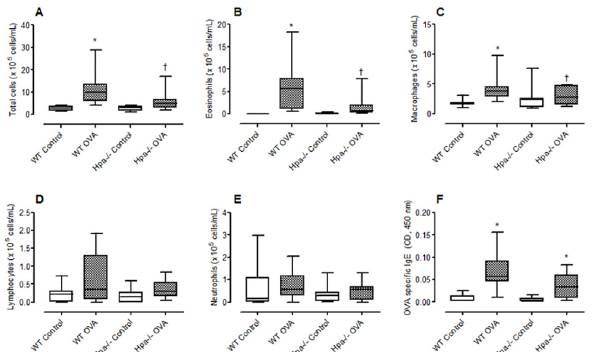
Fig 5. Effect of heparanase gene deletion on allergic inflammation induced by ovalbumin (OVA). Box plots showing (A) total cell, (B) eosinophil, (C) macrophages, (D) lymphocytes, (E) neutrophils in bronchoalveolar lavage fluid and (F) OVA specific IgE in serum in control and OVA immunized and challenged mice. Mice were sensitized by repeated i.p. injections with 10 μ g OVA or were non-sensitized (controls). All mice received three i.n. instillations with 20 μ g OVA and lavage was undertaken 24 h after the last intranasal administration of OVA. Data expressed as blox plots (median, 25 – 75 percentile) with whiskers representing 5 – 95% confidence interval (7 – 12 animals for cell data and 6 – 10 for IgE data). * p < 0.05 compared with control; † No significant difference compared with Hpa -/- control. Data pooled from four independent experiments.